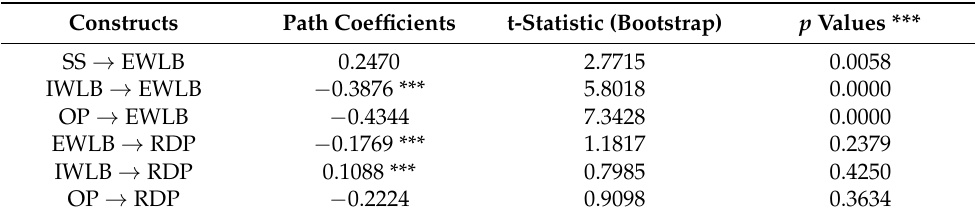
Table 10. Path Coefficients